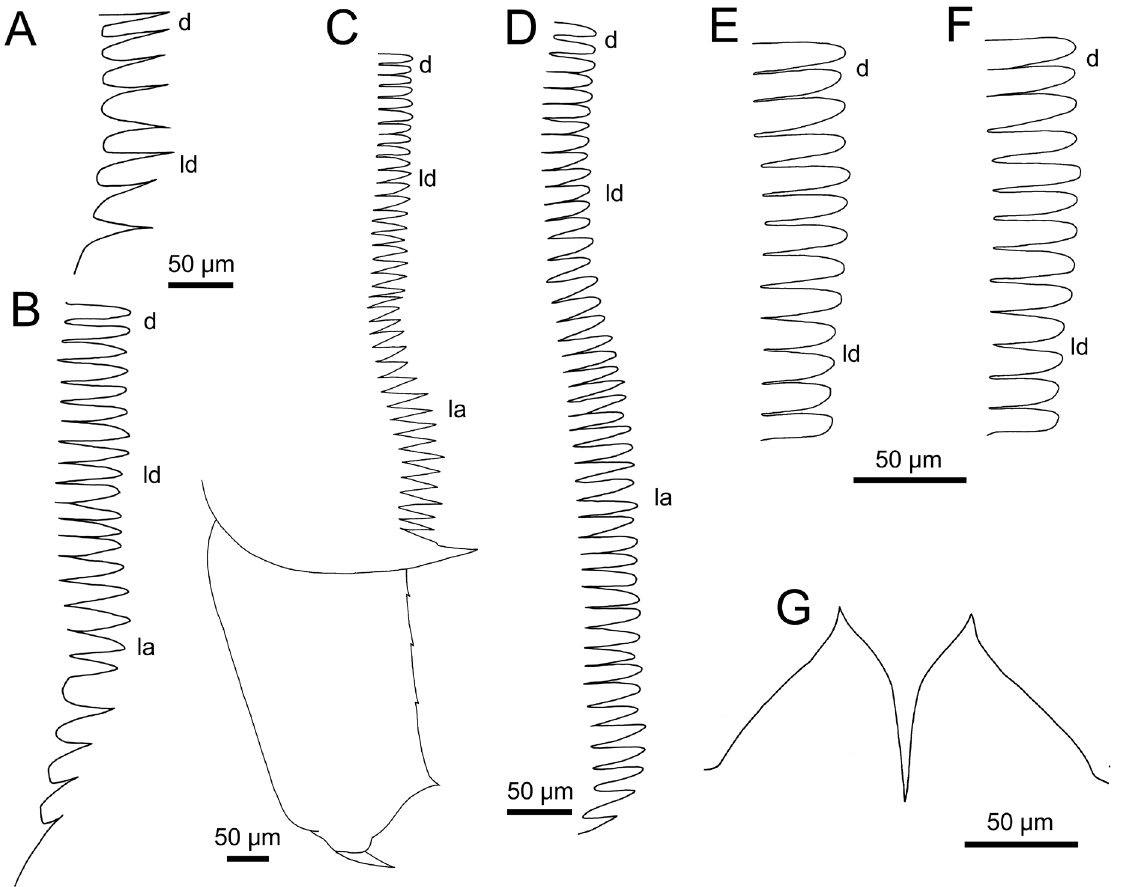
Fig. 14. Sarsinebalia ledoyeri sp. nov. Postovigerous female, paratype (MNCN 20.04/13708). A . Pleonite II, dorsal and laterodorsal posterior border, denticles. B . Pleonite III, dorsal and lateral posterior border, denticles. C . Pleonite IV (posterior border, denticles and epimeron) and pleopod IV (protopod), lateral view. D . Pleonite V, dorsal and lateral posterior border, denticles. E . Pleonite VI, dorsal and laterodorsal border, denticles. F . Pleonite VII, dorsal and laterodorsal border, denticles. G . Anal plates. A–B, E–F: same scale